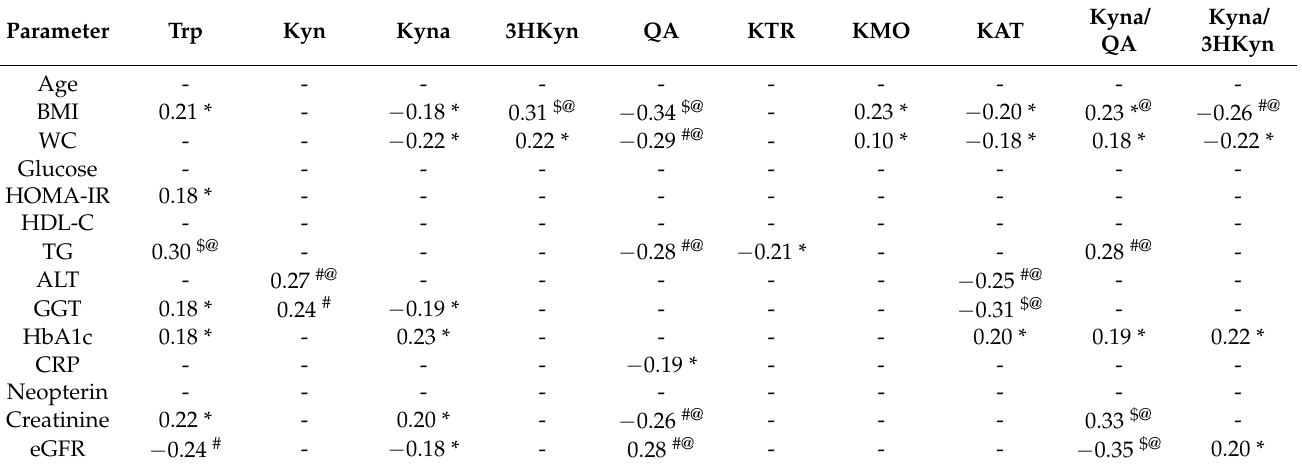
Table 3. The Spearman rank correlation coefficients in all the